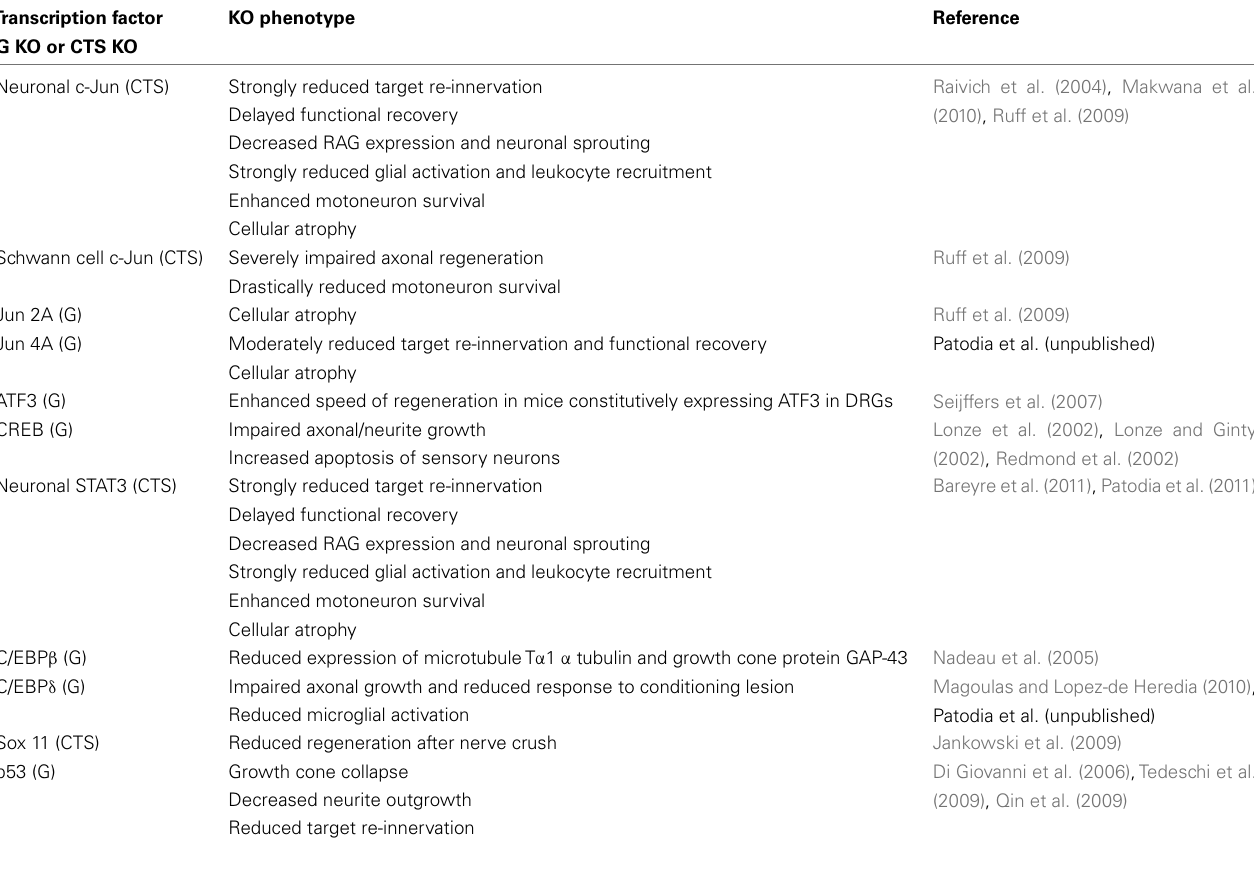
Table 1 |Transcription factor deletions and peripheral nerve regeneration: effects of global (G) and cell-type specific (cts) knockouts